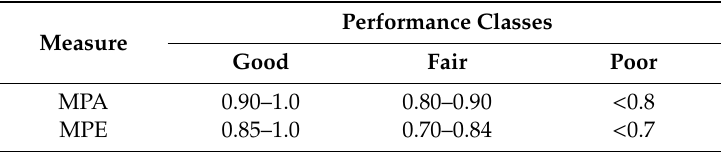
Table 3. Performance standards by Molden and Gates